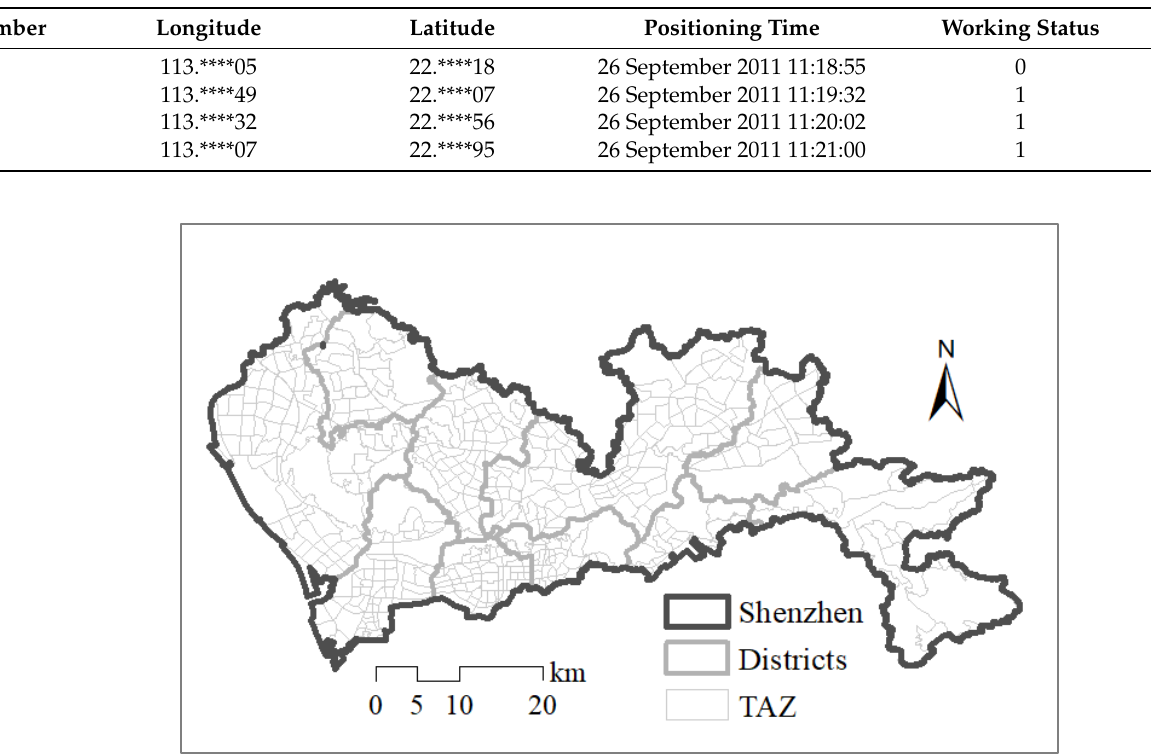
Figure 3. TAZs in